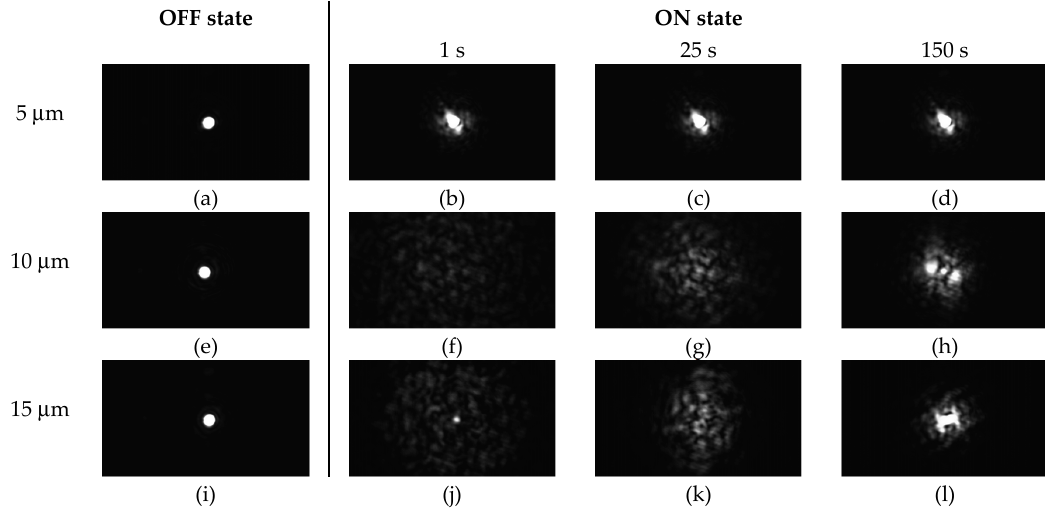
Figure 9. Spectral intensity distribution of a focused beam transmitted by cells of thickness of 5 μ m, 10 μ m and 15 μ m when the cells are driven with the voltage of V = 2.65 V, 2.15 V and 2.15 V, respectively. Figure 9a,e,i represent the focused condition at V = 0. The images of scattered beam are recorded by a CCD camera placed at Fourier plan after different times’ lag detection. The SOP of the incident light is linear H polarized.